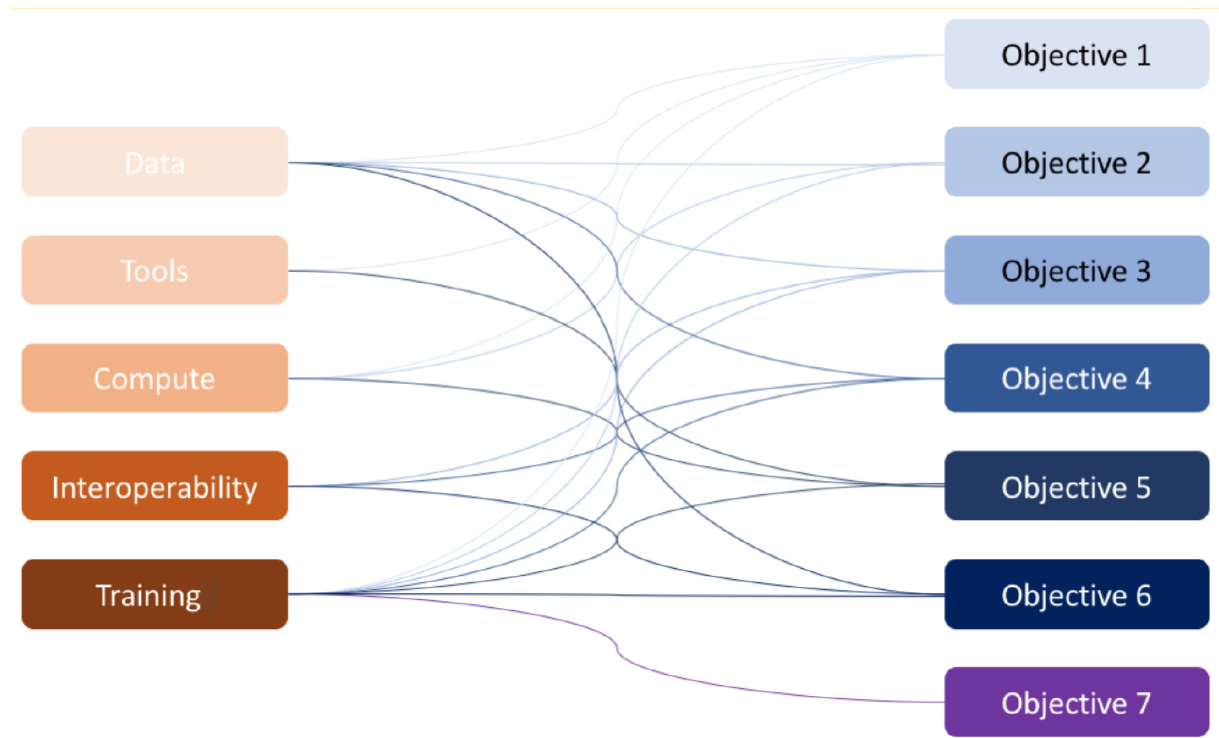
Figure 1. Interactions of the hCNV Community objectives with the ELIXIR platforms. Left: ELIXIR Platforms; Right: ELIXIR hCNV Community